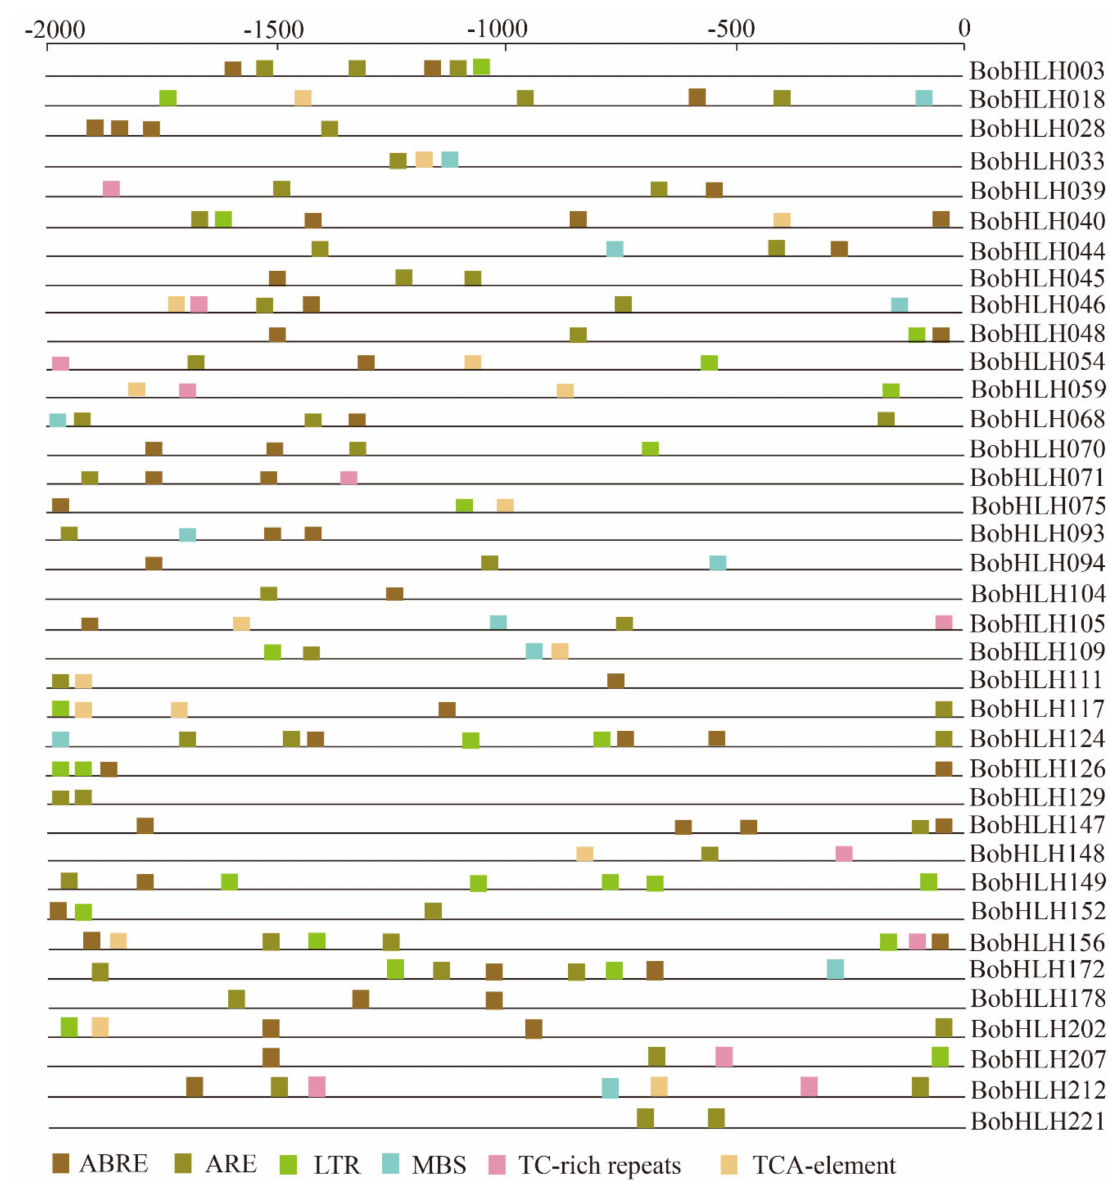
Figure 7. Cis -acting elements in the 2000 bp promoter regions of the chilling-responsive BobHLH